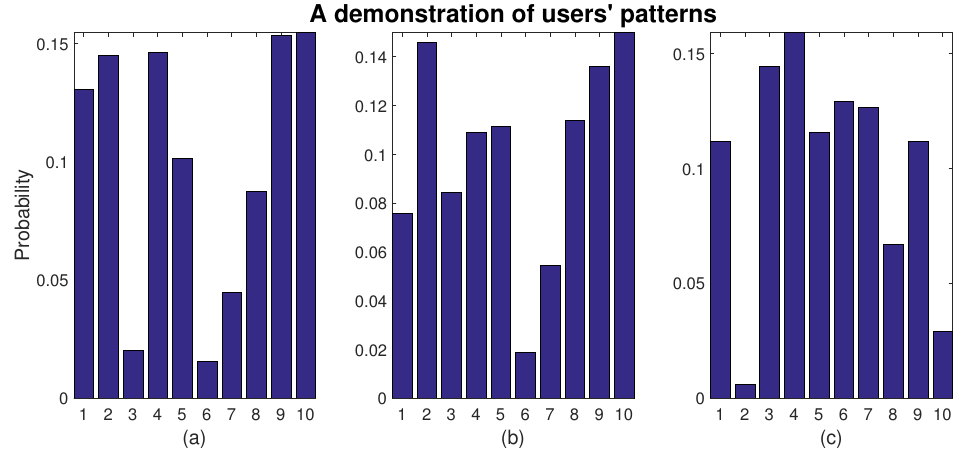
Figure 2. A demonstration of users’ patterns and correlations. The x-axis is the number of categories of data, whereas the y-axis is the probability. corr ( P ( a ) , P ( b )) = 0.8064 and corr ( P ( a ) , P ( c )) = − 0.4587, indicating the similarity of users ( a ) and ( b ) and the dissimilarity of users ( a ) and ( c ), which can also be found clearly from the